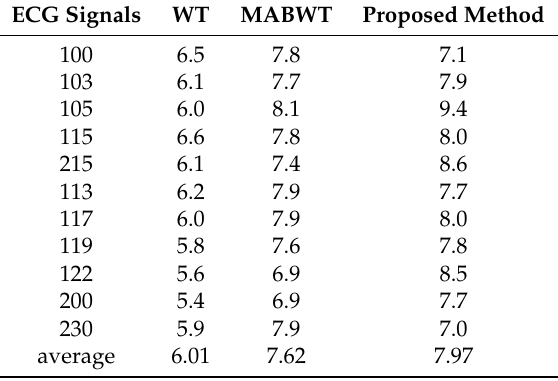
Table 2. SNR imp comparison of de-noising results using soft threshold for ECG signals with WGN (5 dB). ECG Signals WT